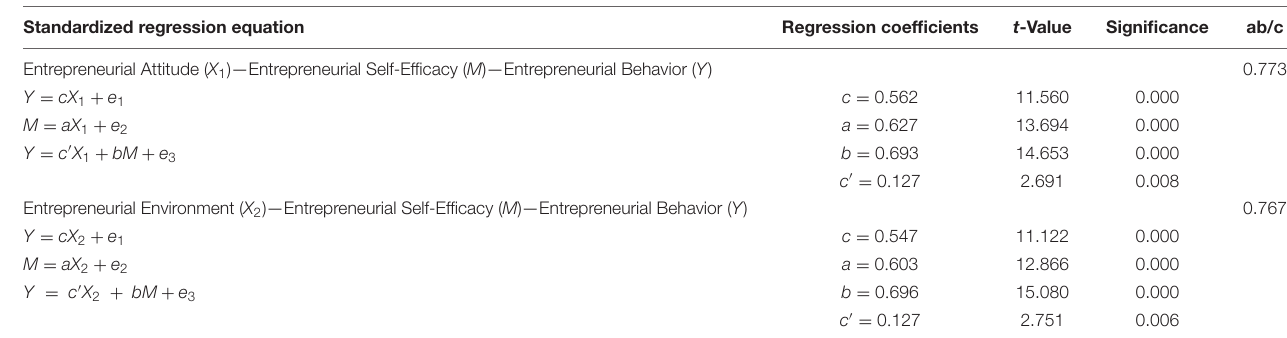
TABLE 5 | Mediating effect